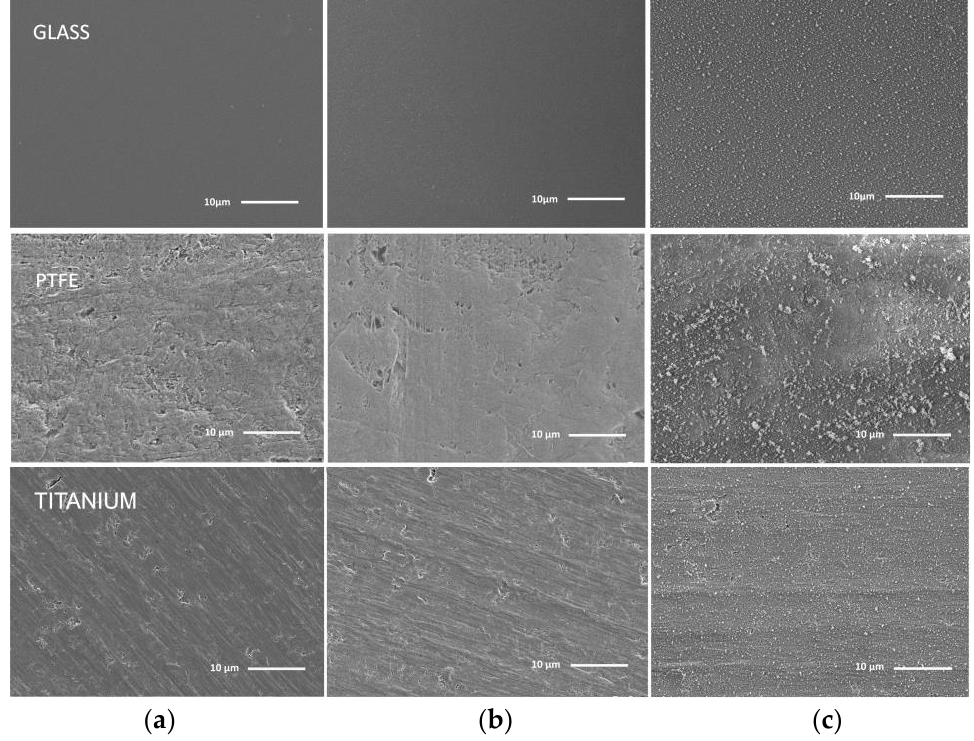
Figure 9. Scanning electron microscopy (SEM) images of thin films deposited on glass, PTFE and titanium in DC plasma jet (nitrogen / air): ( a ) Control, ( b ) Condition A, and ( c ) Condition B, respectively.